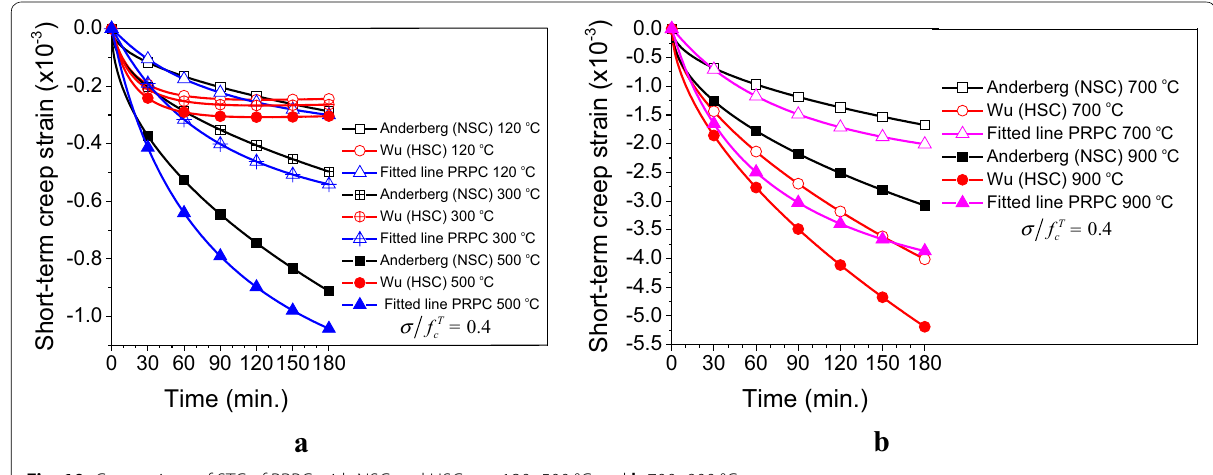
Fig. 10 Comparison of STC of PRPC with NSC and HSC at a 120–500 °C and b 700–900 °C.